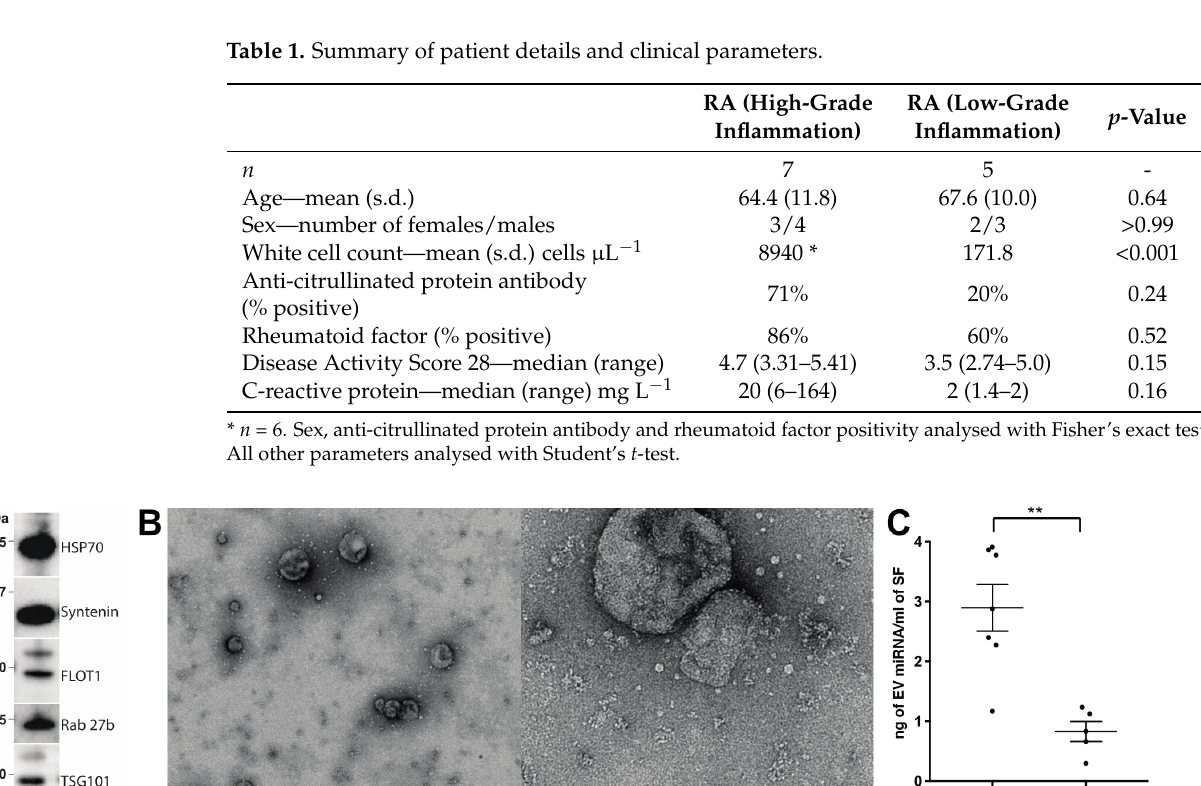
Table 2. Highest-ranked SF EV miRNAs across the entire patient cohort. miRNA Average Expression (CPM)